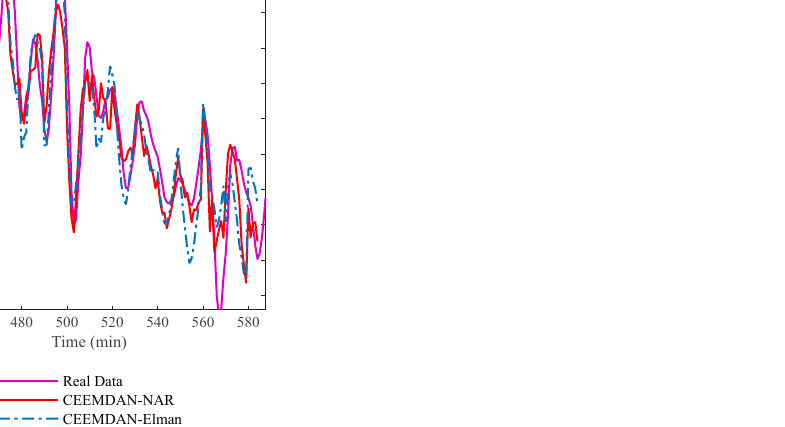
Figure 13. Using CEEMDAN to predict at different starting points (450 min).